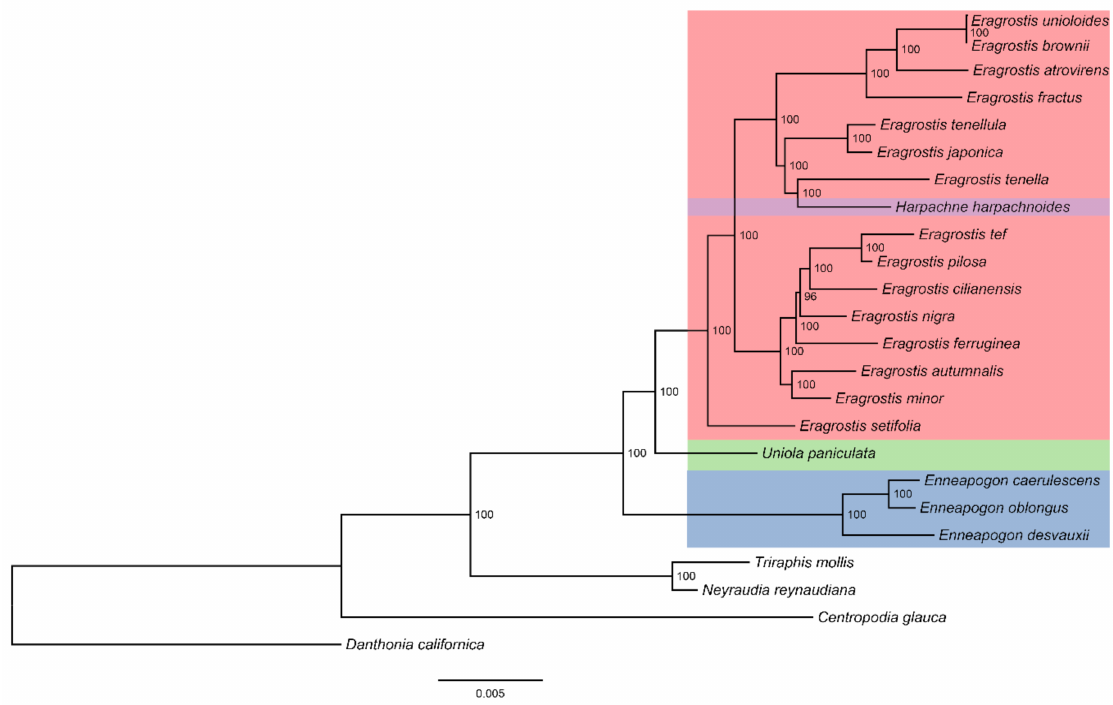
Figure 8. The maximum likelihood phylogenetic tree of 20 Eragrostideae species based on the complete chloroplast genomes. The numbers next to the branches are bootstrap support (BS)